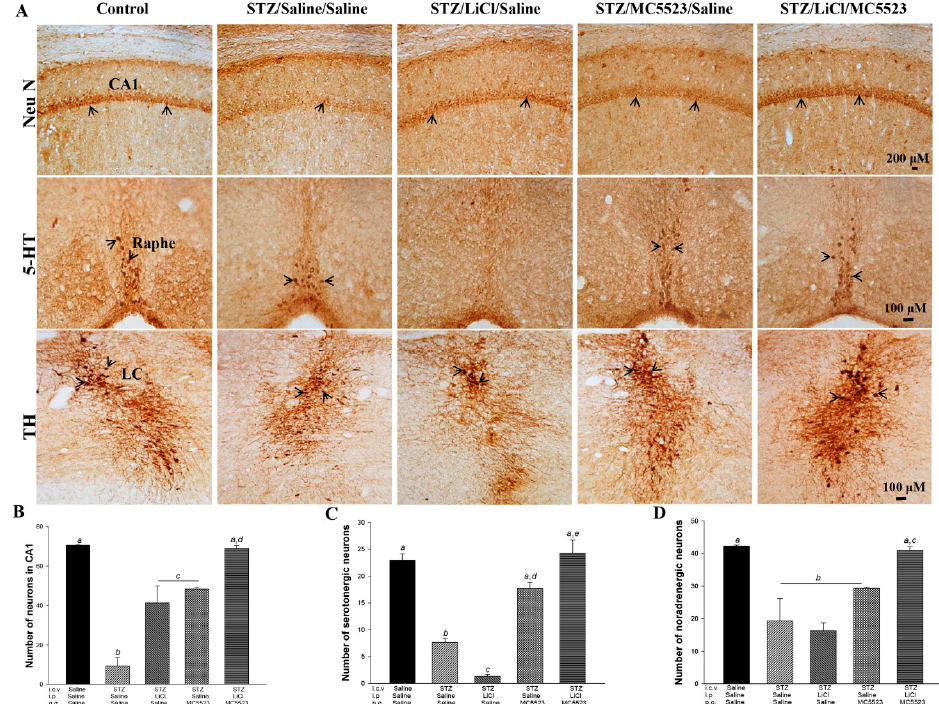
Figure 2. Cotreatment with LiCl and MC5523 greatly prevented neuronal loss in the icv-STZ OVX 3 × Tg-AD mice. ( A ) Representative images of pyramidal neurons in the CA1 subregion of the hippocampus, serotonergic neurons in the Raphe nucleus, and noradrenergic neurons in the locus coeruleus (LC). Scale bars are 200 µ m in the CA1 subregion and 100 µ m in the Raphe nucleus and LC. ( B – D ) The number of pyramidal neurons in the CA1 subregion of the hippocampus, serotonergic neurons in the Raphe nucleus, and noradrenergic neurons in the LC. The results reveal the robust beneficial effect of LiCl combined with MC5523 on pyramidal, serotonergic, and noradrenergic neurons ( n = 3 per group). Arrowheads indicate positive staining signals. The quantitative data are shown as the mean ± SEM ( n = 3 per group). Means that do not share a letter are significantly different ( p < 0.05).